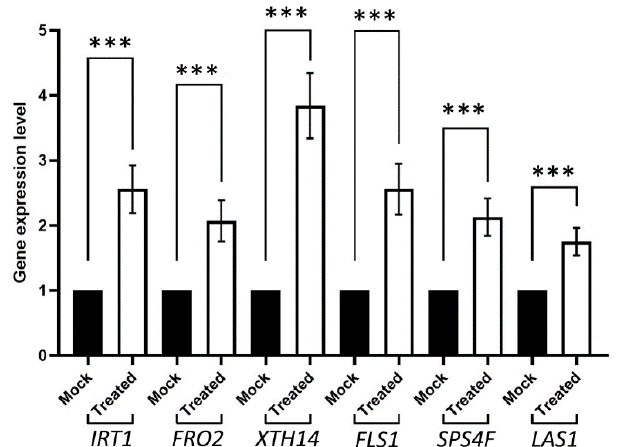
Figure 3. Relative expression levels of key genes. The bar graph shows representative quantitative real-time PCR results from three independent experiments (each one with n = 3 biologically inde- pendent samples) for key genes in the areas of interest highlighted by transcriptomic analysis. Asterisks (***) stand for p -values > 0.001. Error bars represent s.d